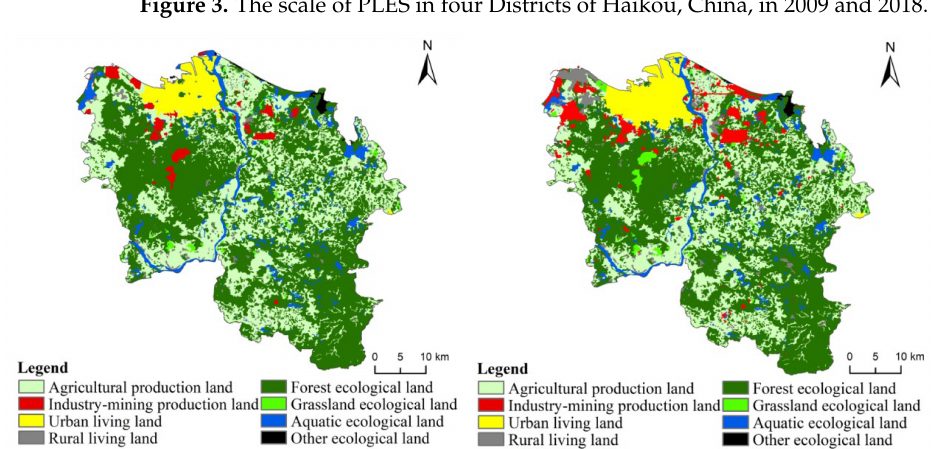
Figure 4. The spatial distribution pattern of land use functions in Haikou in 2009 and 2018.